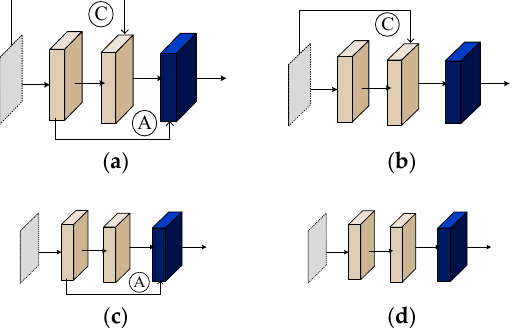
Table 8. Quantitative evaluation of cloud removal algorithms with and without add operation in each block. w/o is short for